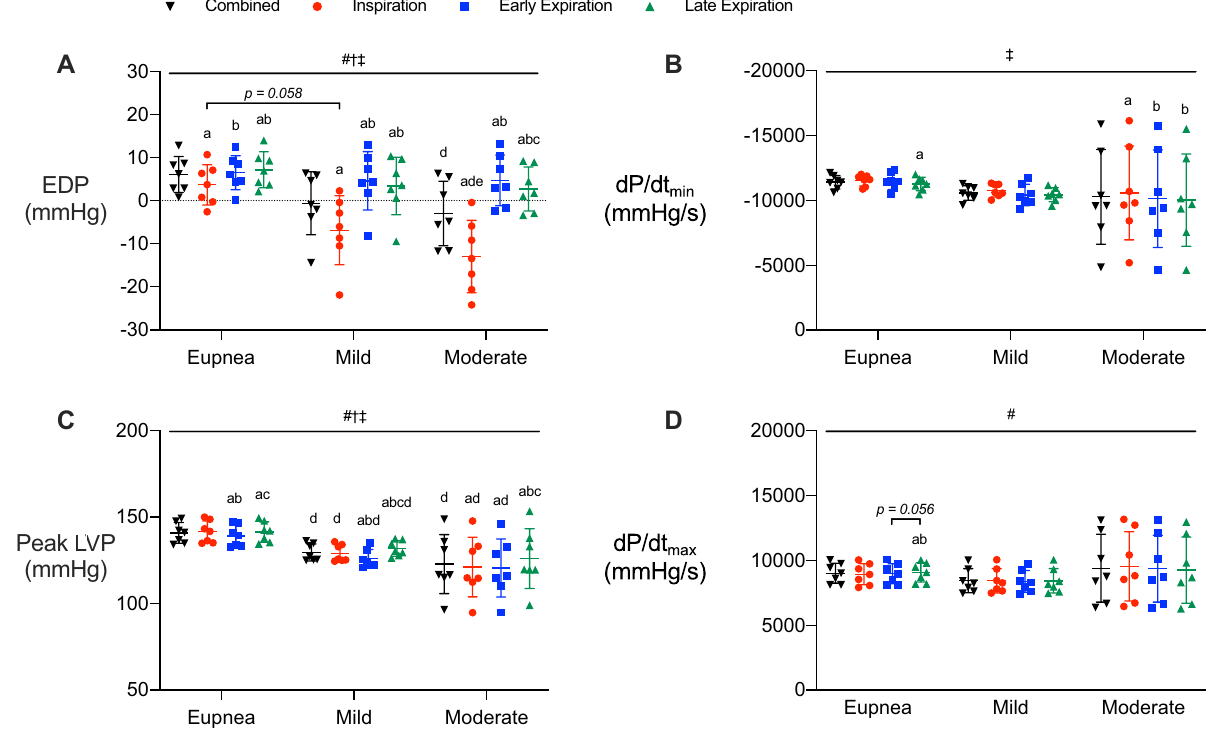
Figure 3. Cardiac function is influenced by respiratory phase and load. Parameters are shown prior to separating by respiratory phase (black; combined) and during inspiratory (red), early expiratory (blue), and late expiratory (green) phases during eupneic breathing and mild and moderate resistance loads. ( A ) End diastolic pressure. ( B ) dP/dt min . ( C ) Peak left ventricle pressure. ( D ) dP/dt max . Data are presented as mean ± SD. #, significant interaction; †, main effect of respiratory load; ‡, main effect of respiratory phase; a, different from combined within a respiratory load; b, different from inspiration within a respiratory load; c, different from early expiration within a respiratory load; d, different from eupnea within a respiratory phase; e, different from mild resistance within a respiratory phase; p < 0.05 for all. All data were analyzed using a within-subject two-way ANOVA with main effects evaluated with one-way repeated measures ANOVAs and Sidak’s correction, n =